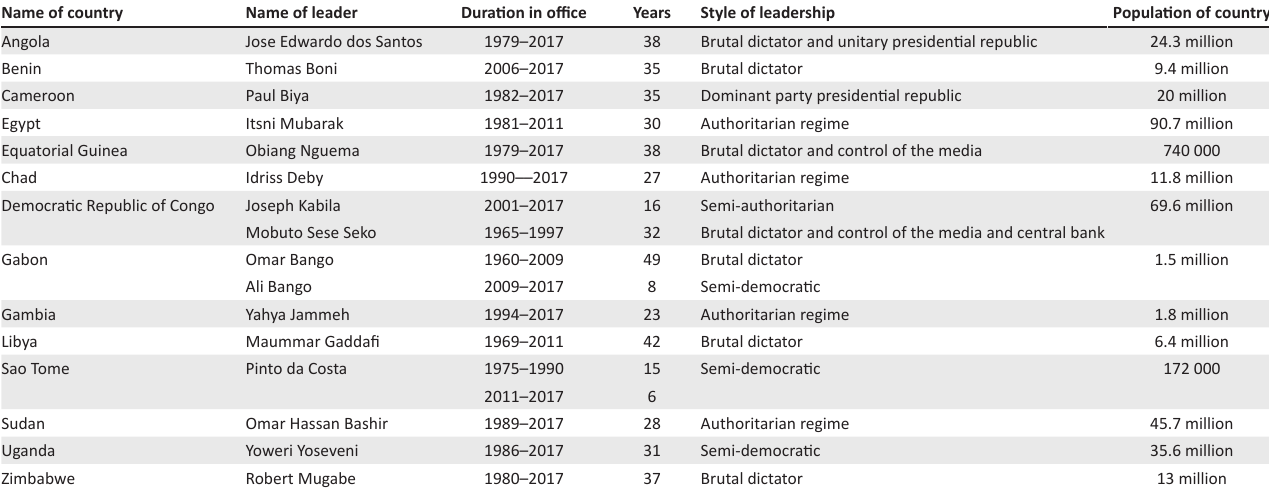
TABLE 8: Nature of political leadership in selected African countries. Name of country Name of